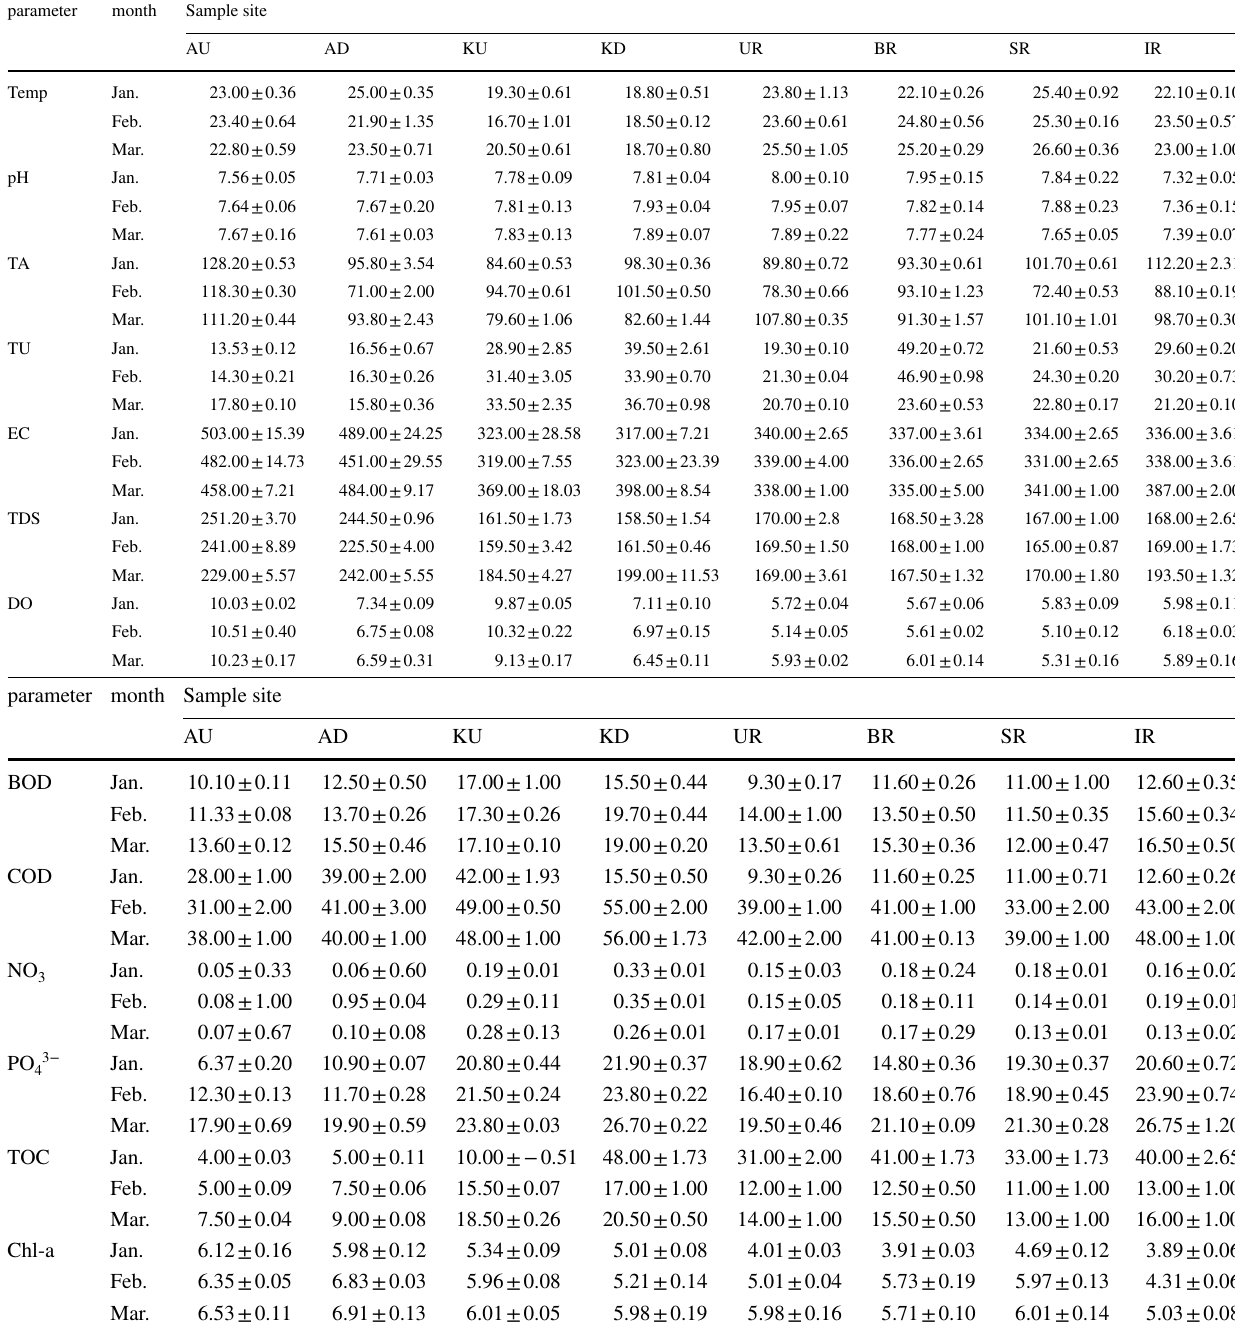
Table 1 Limnological physico-chemical water quality parameters of Angereb reservoir and tributaries (Mean ±